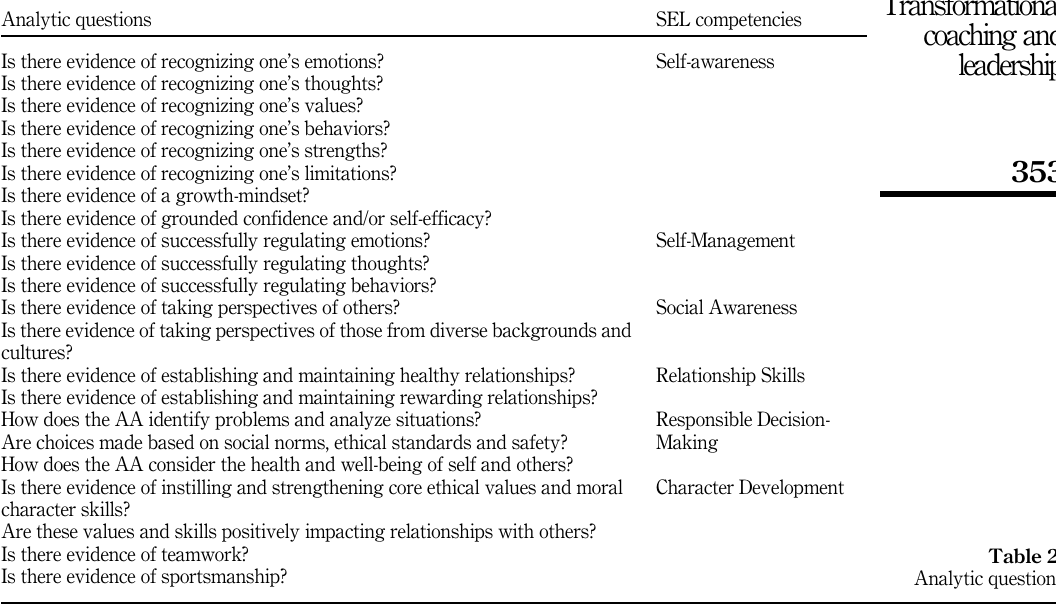
Table 2. Analytic